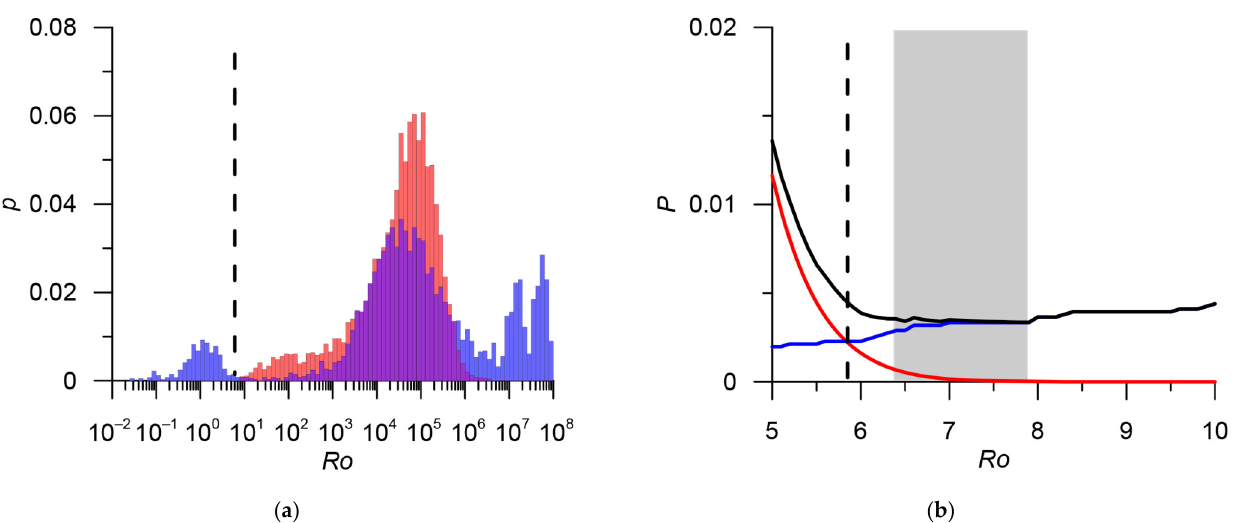
Figure 4. ( a ) Comparison of the metric distribution for YAK/NER pairs (blue histogram) and the same metric for YAK/YAK earthquakes (red histogram). ( b ) Threshold optimization: the red line shows the probability of missing a duplicate in the model with metric (1), the blue line is the probability of a false duplicate (see text), the black line is the total probability of errors of the first and second kind, the dashed line Ro = 5.8 corresponds to an equal number of errors of the first and of the second kind (the number of false duplicates is equal to the number of missed duplicates), the estimate of the total number of errors is approximately 0.5%, and the gray bar shows the range of values for the metric Ro = 6.3 ÷ 7.9, minimizing the total number of errors (approximately 0.4%).